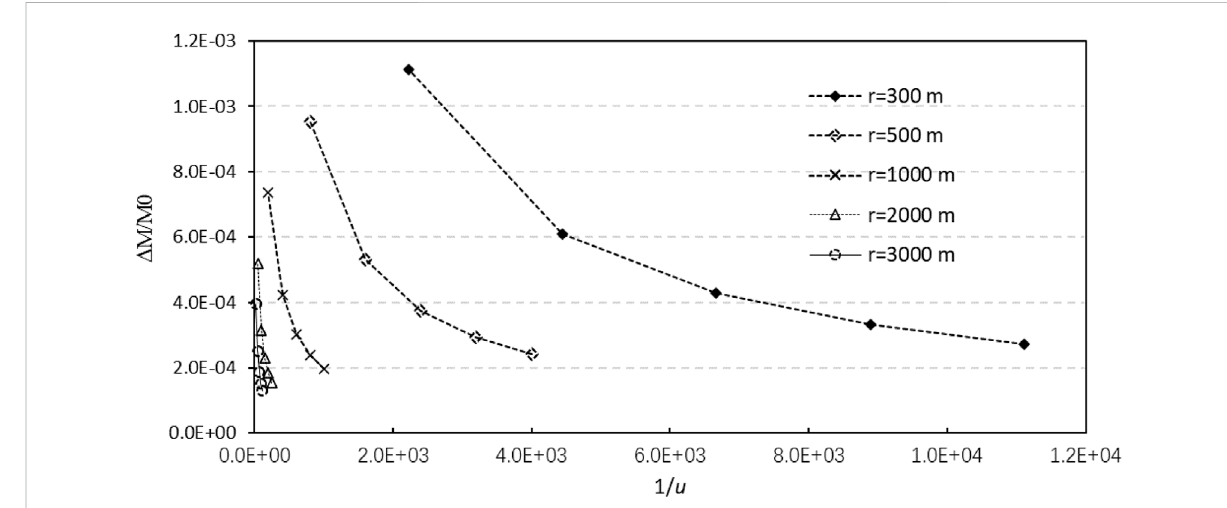
FIGURE 4 Plots of dimensionless compression Δ M / M 0 as a function of 1/ u